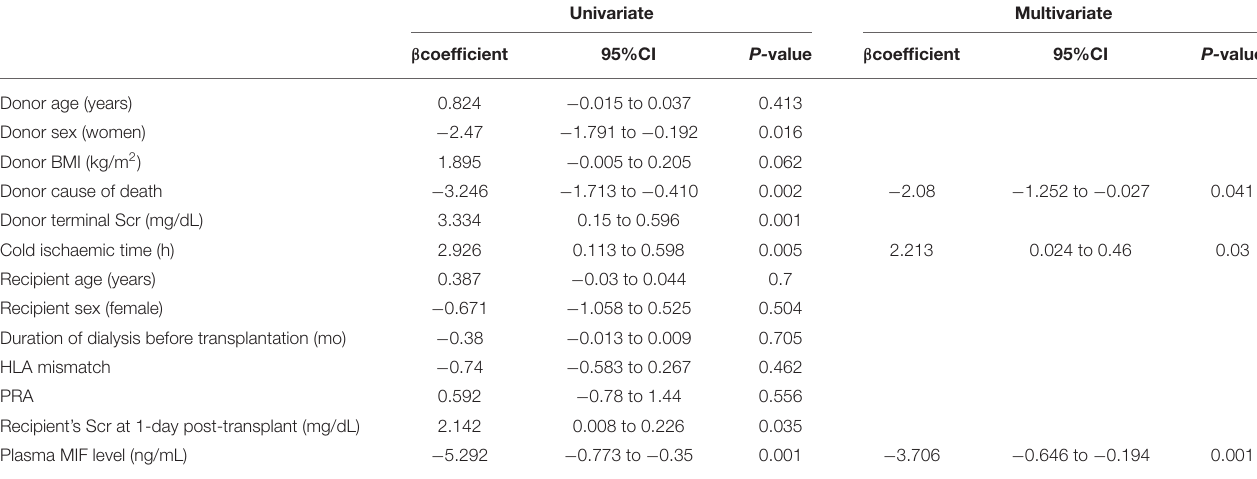
TABLE 4 | Univariate and multivariate linear regression analyses for predicting 1-month graft function.